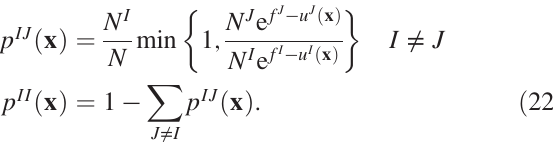
Algorithm 1: xTRAM Algorithm for estimating the free energies f I and equilibrium probabilities π I